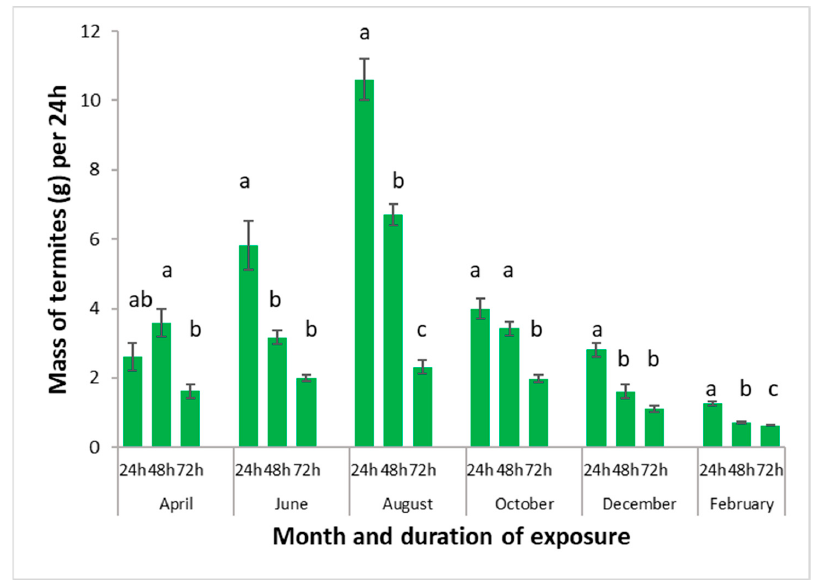
Figure 9. Average masses of termites harvested per container and per 24 h, according to trapping duration. Error bars represent standard errors. Histograms with the same letter in the same month are not significantly different at the 5%